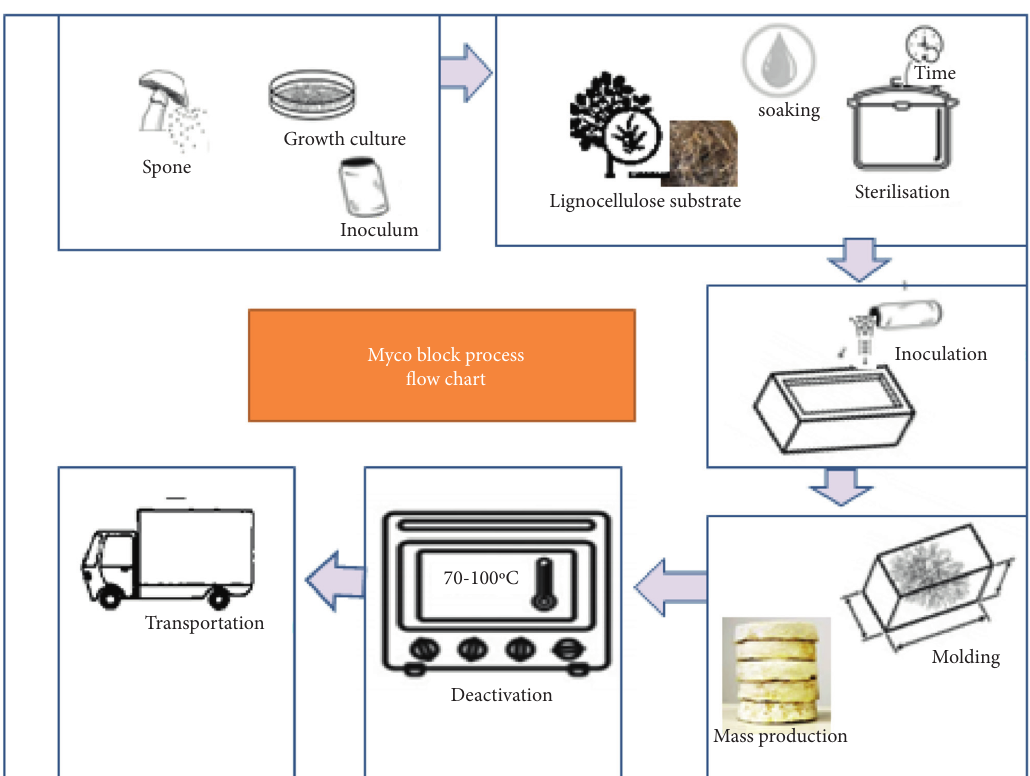
Figure 2: Flowchart showing production of mycelium-based composite (adopted from